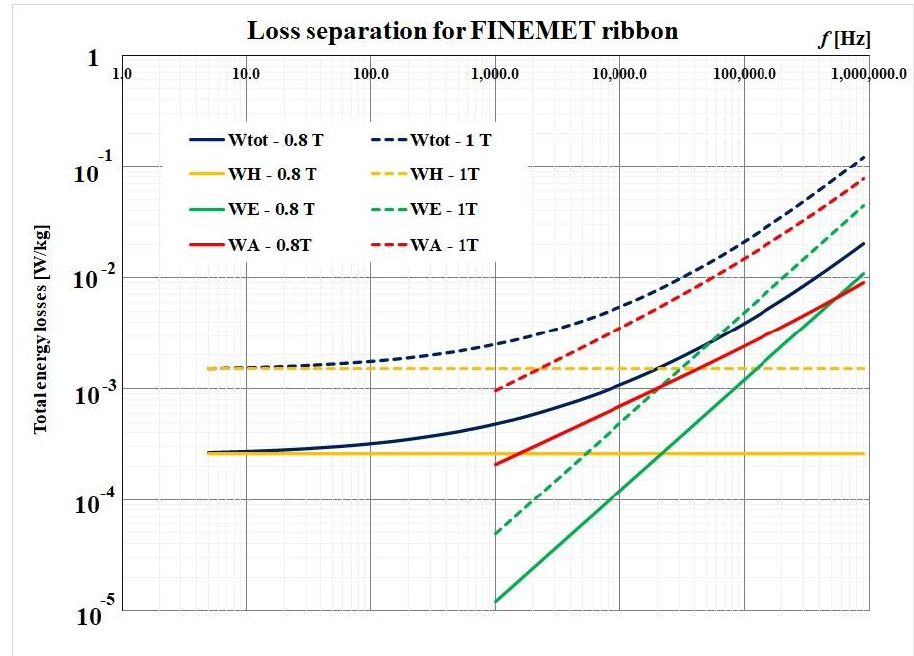
Figure 10. Loss separation procedure for 500 mT and 1 T, respectively.